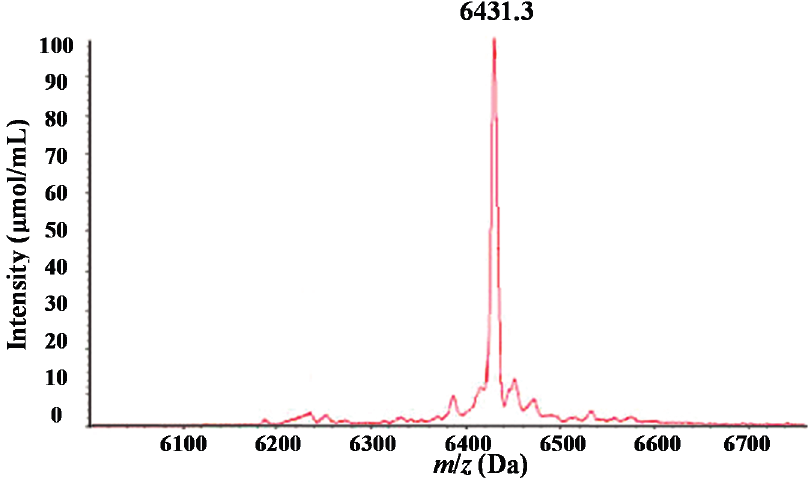
Figure 4. Matrix-assisted laser desorption ionization/time-of-flight mass spectrometry (MALDI–TOF–MS) mass spectrograph of the purified proteins and peptide segments with m / z of 6438